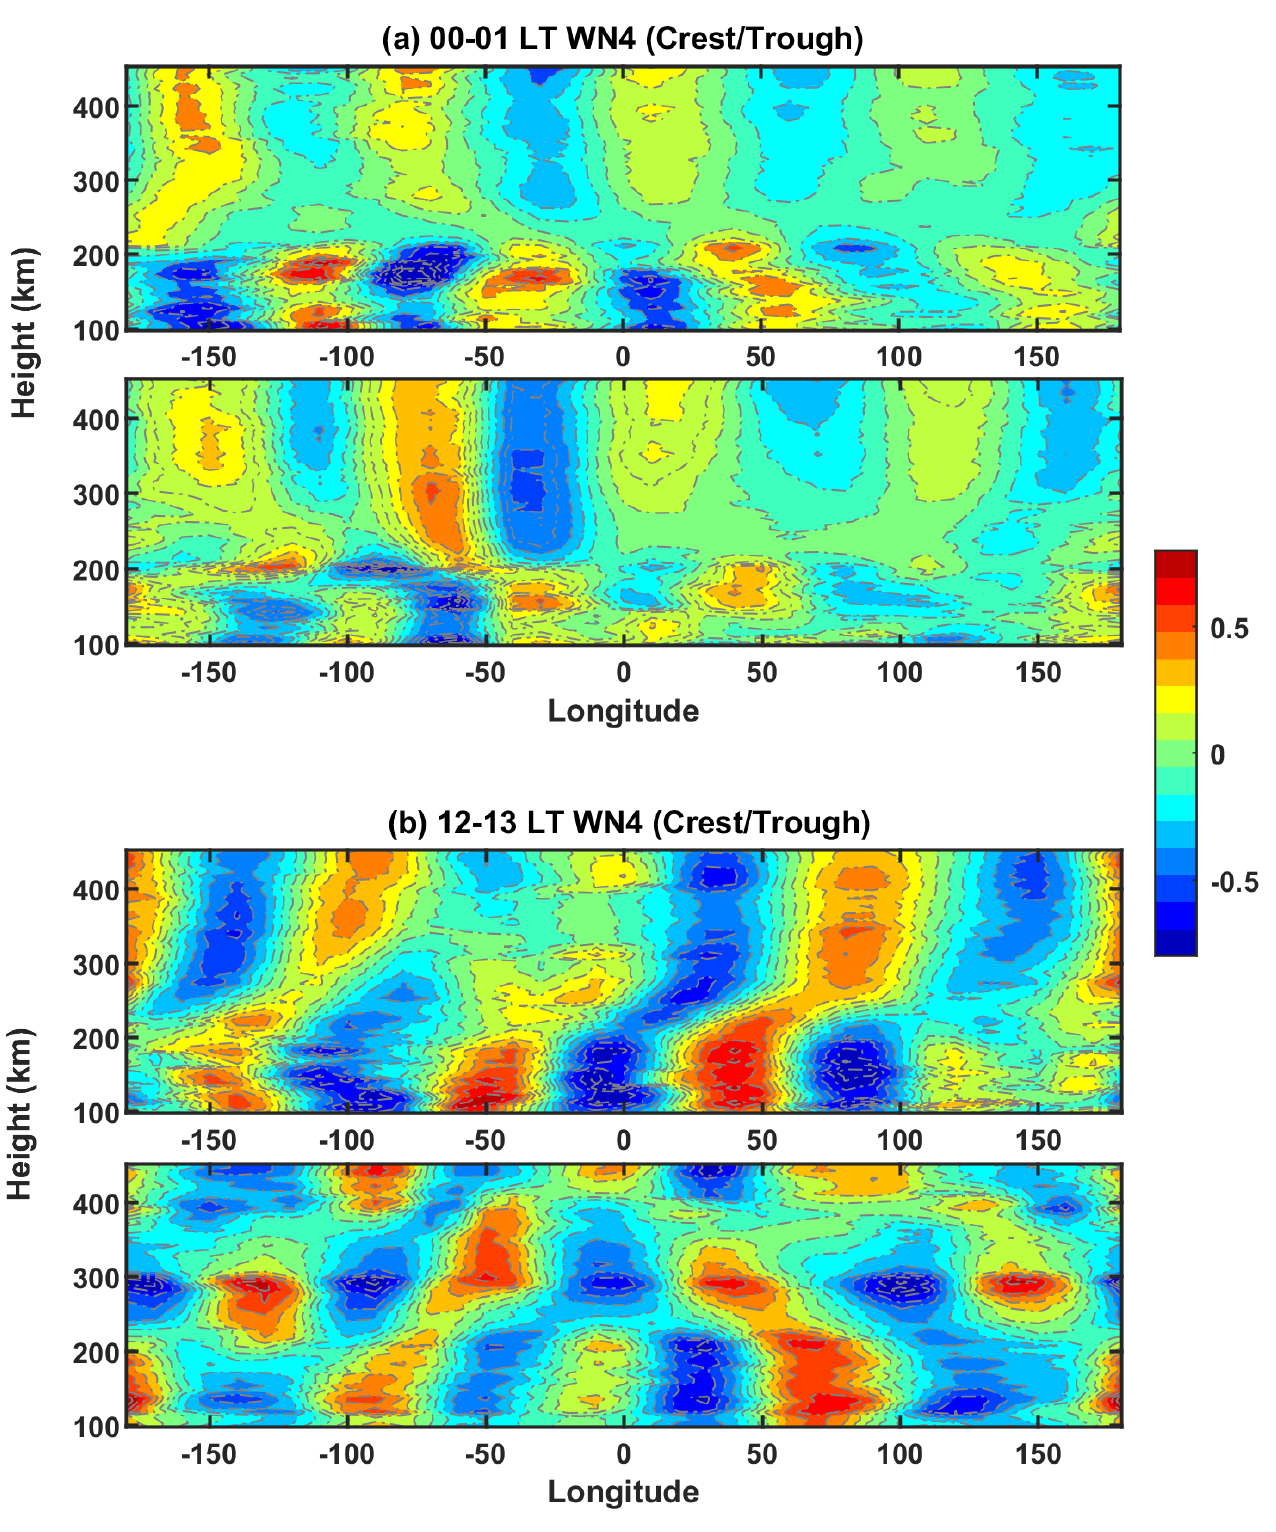
Figure 7. ( a ) Nighttime (local time 00 – 01) contour of normalized electron density in the vertical plane over the EIA crest and trough regions are presented in the top and bottom subpanels, respectively. ( b ) Daytime (local time 12 – 13) contour of normalized electron density in the vertical plane over the EIA crest and trough regions are presented in the top and bottom subpanels, respectively.